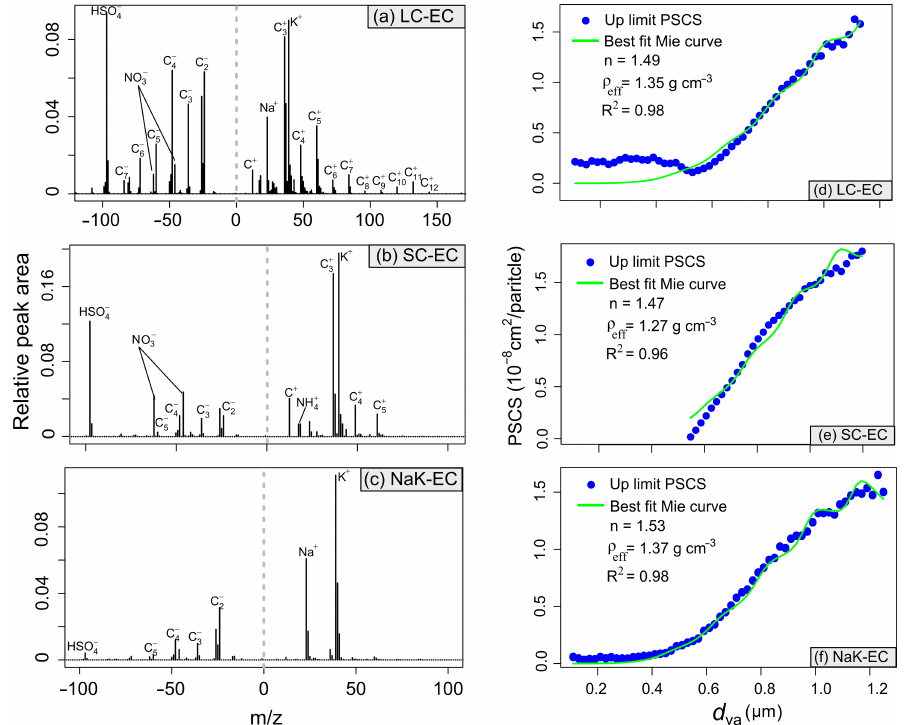
Figure 3. Mass spectra, and measured and best-fit theoretical PSCS for LC-EC, SC-EC, and NaK-EC,